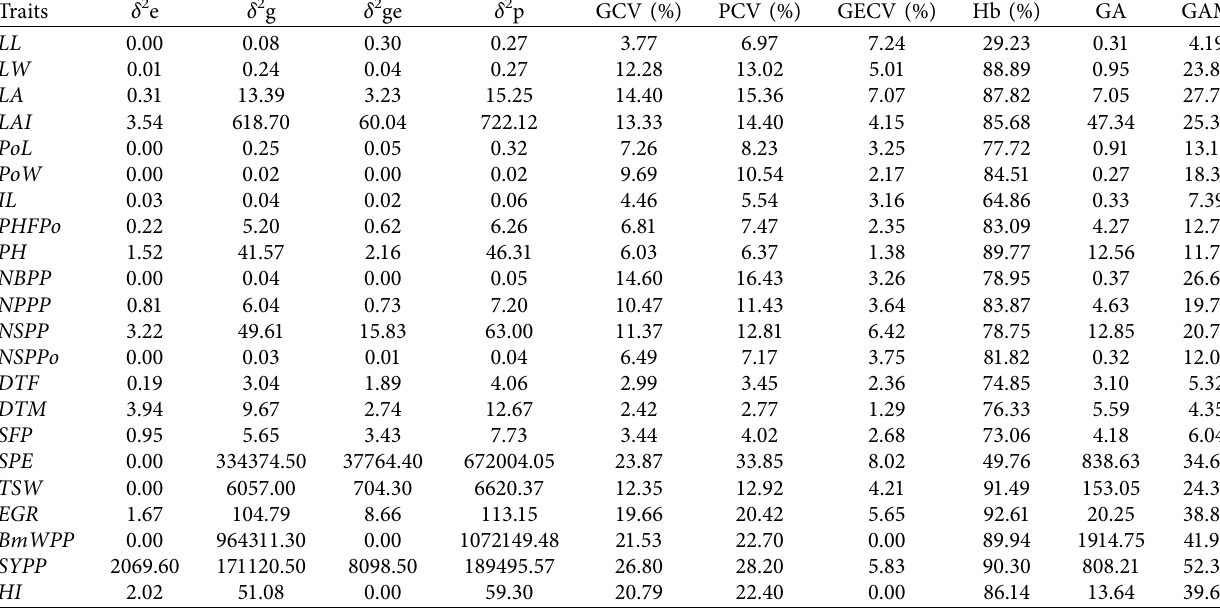
Table 8: Estimate of the variance components in the 22 quantitative traits used to evaluate the performance of faba bean varieties. Traits δ 2